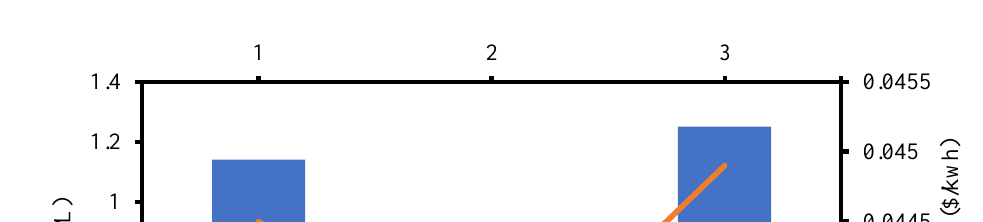
Figure 16. Effect of fuel price variation on NPC.